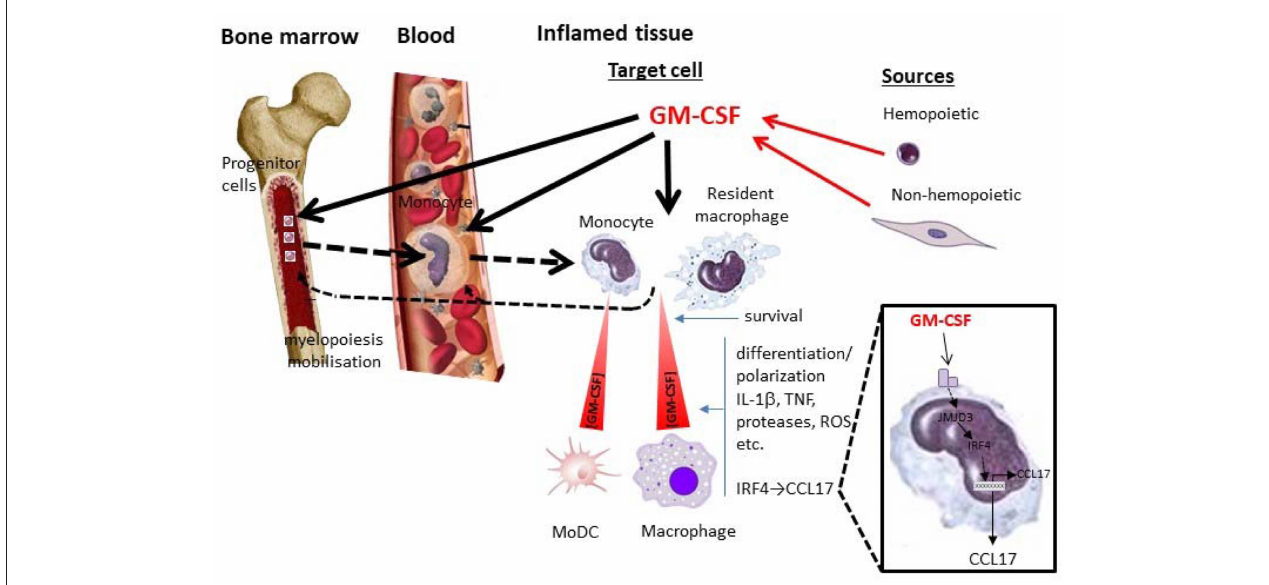
FIGURE 1 | GM-CSF and monocytes/macrophages in inflammation. Depicted are some potential local and systemic actions of GM-CSF on monocyte/macrophage populations during an inflammatory reaction. Whether particular actions operate are currently debated and are likely to depend on the nature of the inflammatory reaction and the levels of GM-CSF attained from hemopoietic (e.g., lymphocyte) and non-hemopoietic (e.g., fibroblast) cell populations. Locally GM-CSF can act in a concentration—dependent manner on target cells (resident macrophages and/or blood-derived monocytes) to promote their survival and/or polarization/differentiation; the latter cell target can give rise to MoDCs. Their polarization/differentiation can be characterized by the production of proinflammatory mediators such as cytokines (e.g., IL-1 β , TNF), proteases, reactive oxygen species (ROS), etc. One interesting pathway (zoomed), which seems to be important for GM-CSF-dependent inflammation and associated pain, leads to CCL17 production via JMJD3 and IRF4. GM-CSF can also act systemically in the blood and/or bone marrow, either directly or indirectly ( ) via its cellular targets in the tissue, leading to migration/mobilization of monocytes or their precursors and/or monocyte development from these precursors (myelopoiesis) ( ). MoDC, monocyte-derived